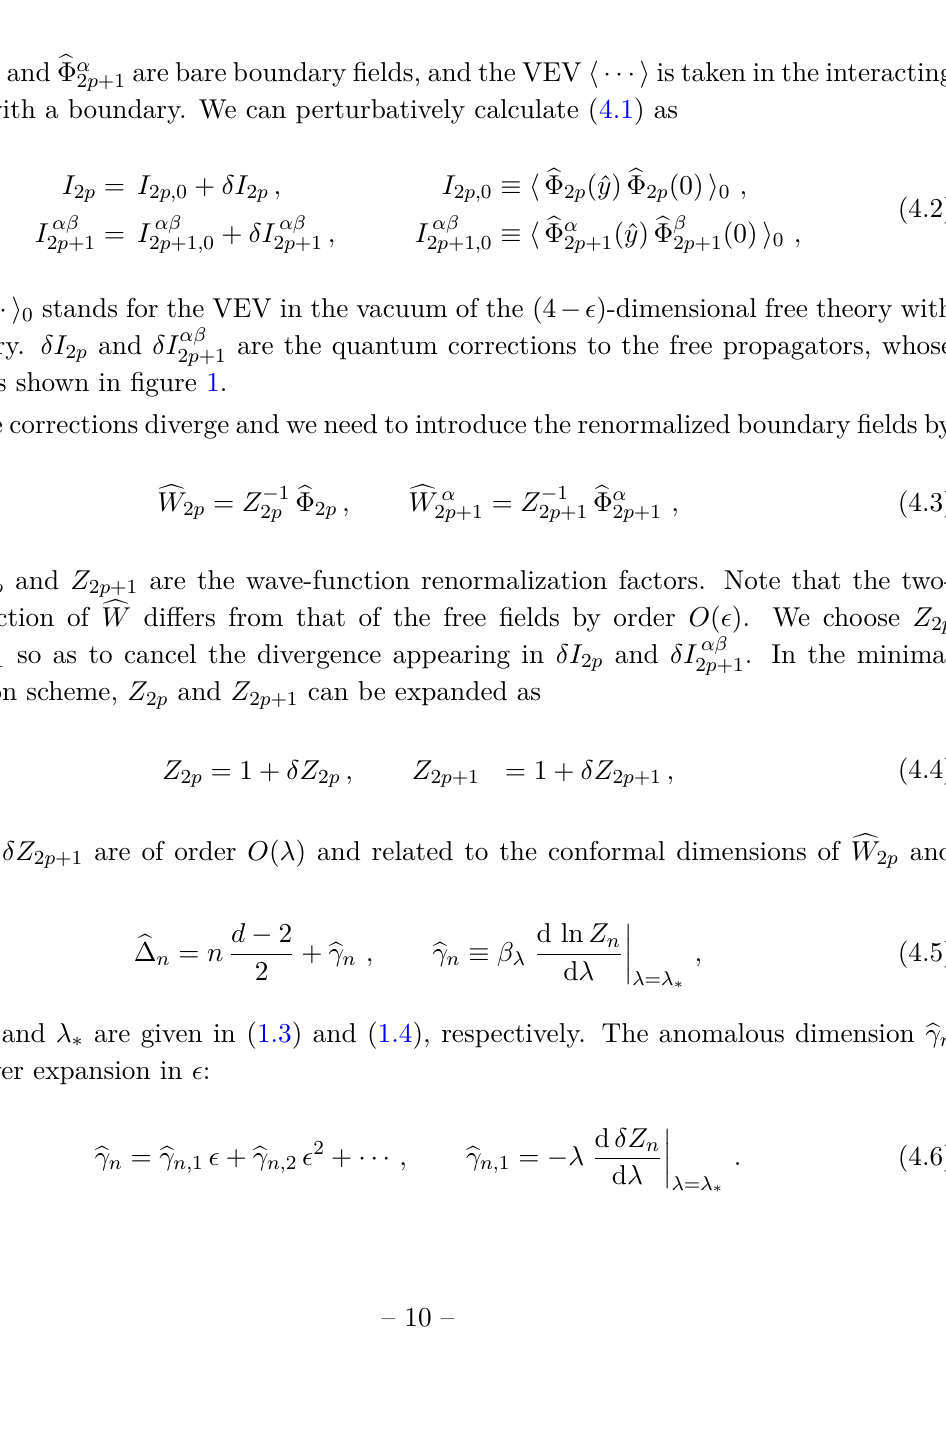
Figure 1 . One-loop diagrams contributing to the anomalous dimensions of the composite operators c W 2 p , c W α 2 p +1 . Black circles ( • ) on the boundary denote boundary operators while black squares ( (cid:4) ) is the bulk | Φ 4 interaction 1 |